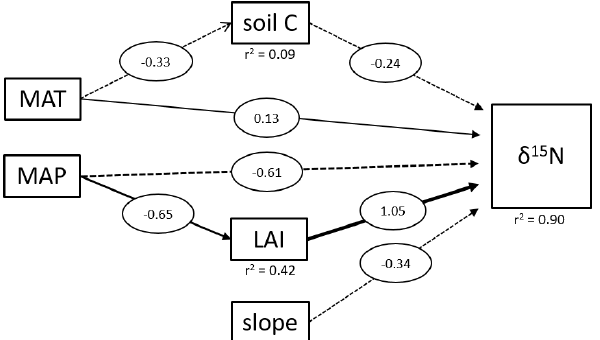
Figure 4. Structural equation model of direct and indirect effects on tropical soil δ 15 N values. The diagram shows all significant rela- tionships. MAT represents the mean annual temperature in degrees Celsius, MAP the mean annual precipitation in millimeters and LAI the leaf area index. Soil C is the carbon content of the soil samples and slope the slope angles of the sampling site. Numbers represent the strength of each